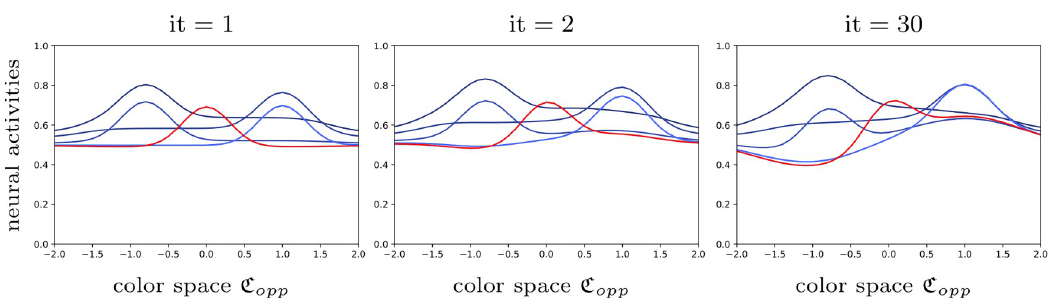
ð r ; �Þ of hypercolumn r 0 corresponding to the 0 q